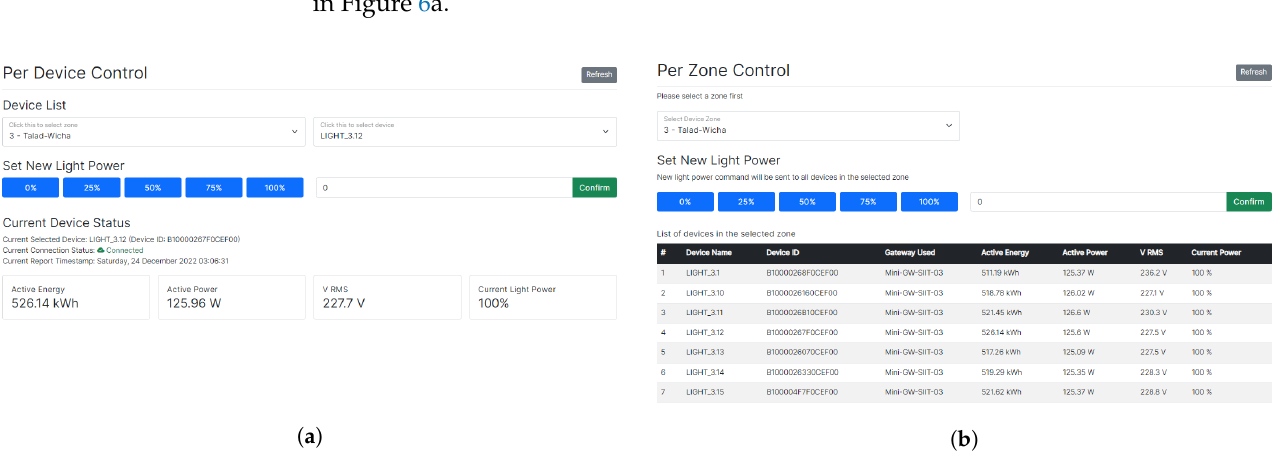
Figure 6. User interface for device control functions. ( a ) Single device control interface. ( b ) Entire zone device control